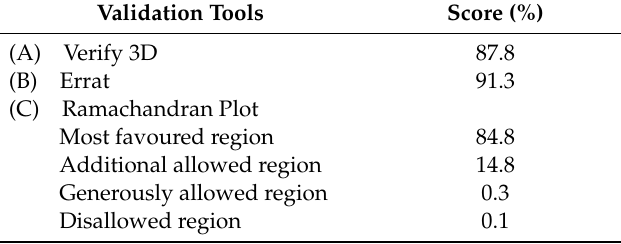
Table 1. The summary score for the predicted structure of GlaEst12 esterase using online web